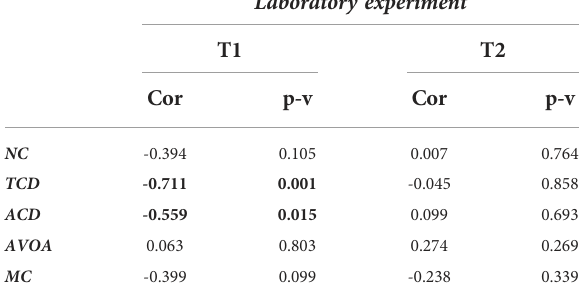
TABLE 1 Correlation between PSTm content in mussel tissues at the end of the controlled laboratory experiment and the behavioural indicators measured in the controlled laboratory experiment before (T0) and during A. catenella exposition (T1), then and food addition (T2).